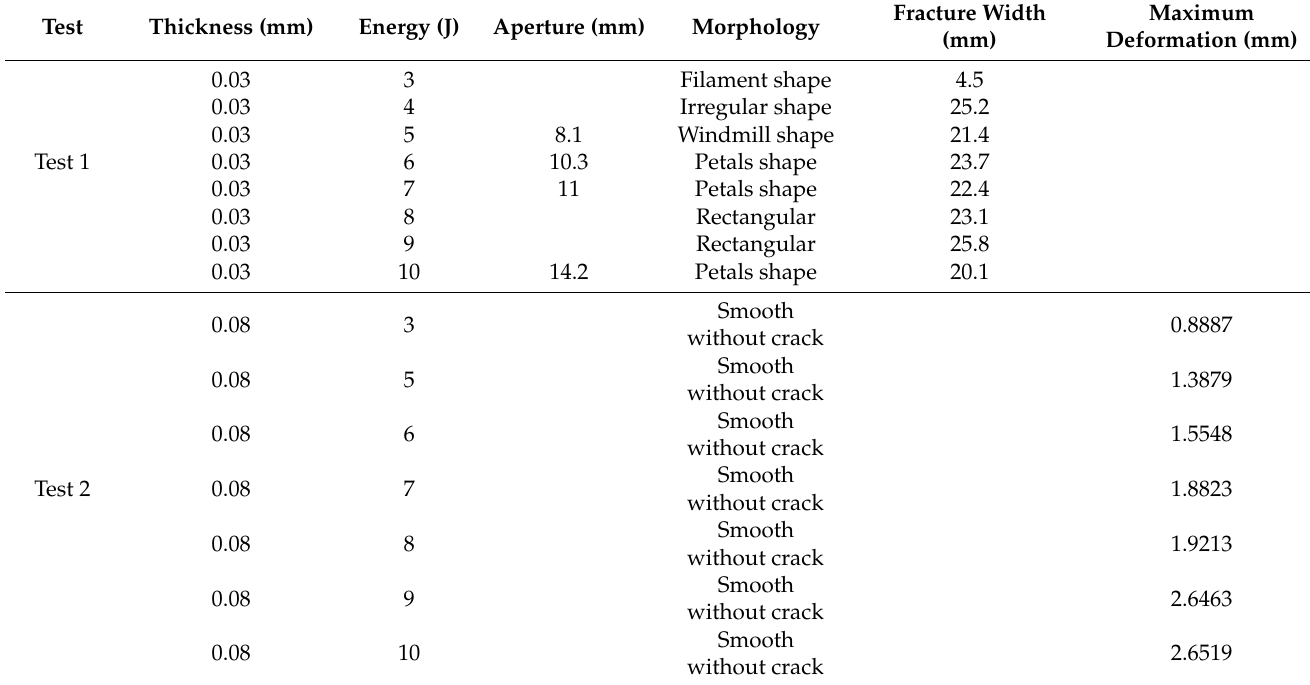
Table 3. Measurement of experimental data in Test 1 and Test